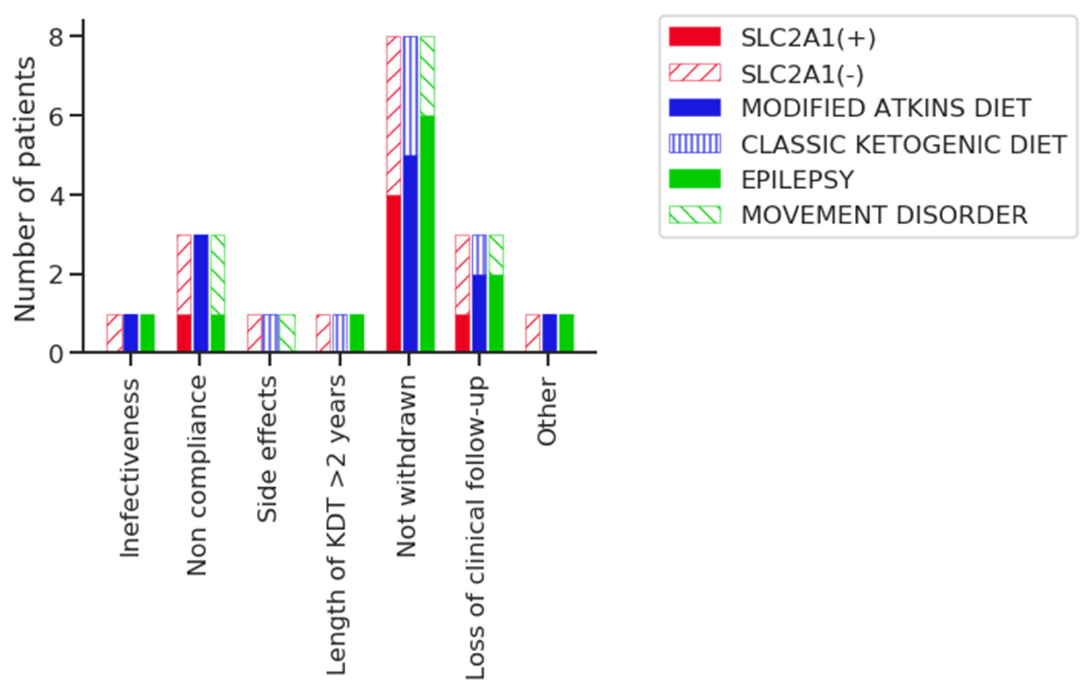
Figure 1. Reasons for withdrawing ketogenic dietary therapies (KDT) according to the SLC2A1 gene mutation, type of KDT, and symptoms.